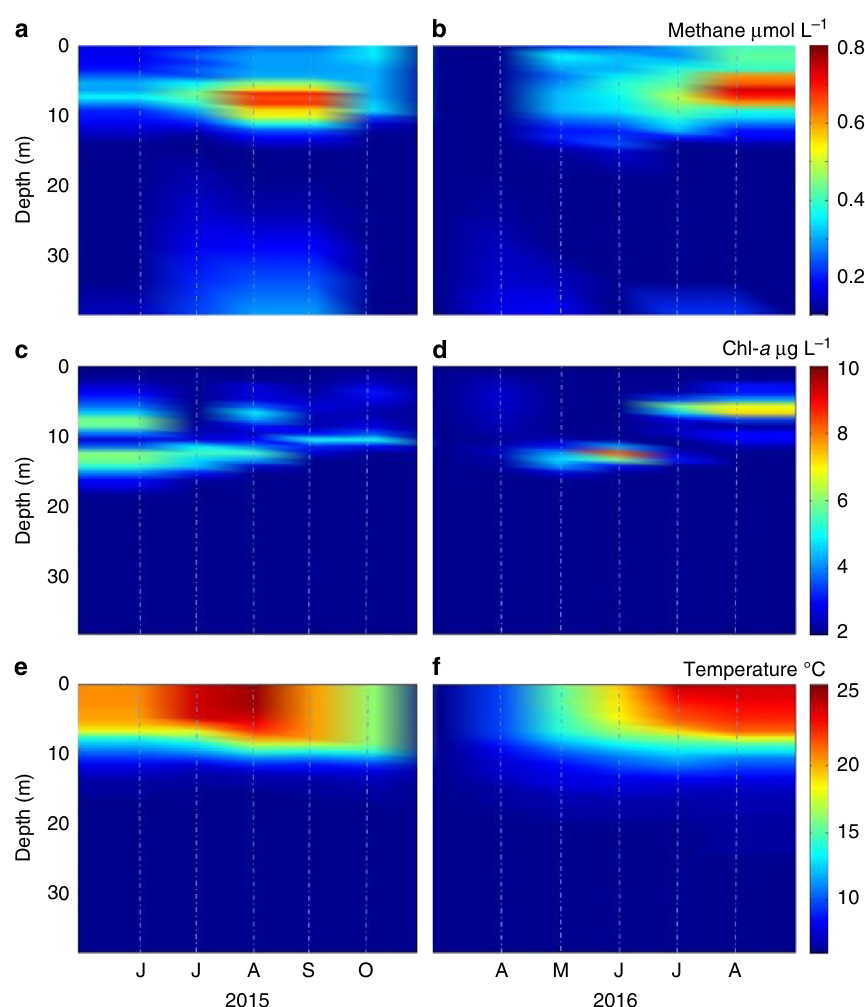
Fig. 2 Evolution of dissolved CH 4 in the water column (0 – 40m) of Lake Hallwil. Dissolved CH 4 ( µ mol L − 1 ) in a and b , chlorophyll a (Chl- a ; µ g L − 1 ) in c and d and temperature (°C) in e and f from June – October 2015 to April – August 2016 interpolated from measurements at the lake center (47°16.762 N, 8°12.791 E, St. A, Supplementary Fig. 1). Dashed vertical lines indicate the sampling